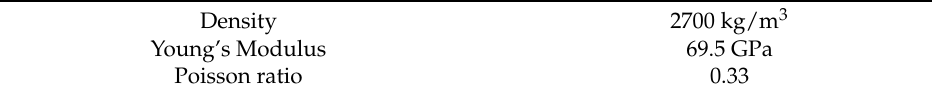
Table 1. Material properties used in the FE model.